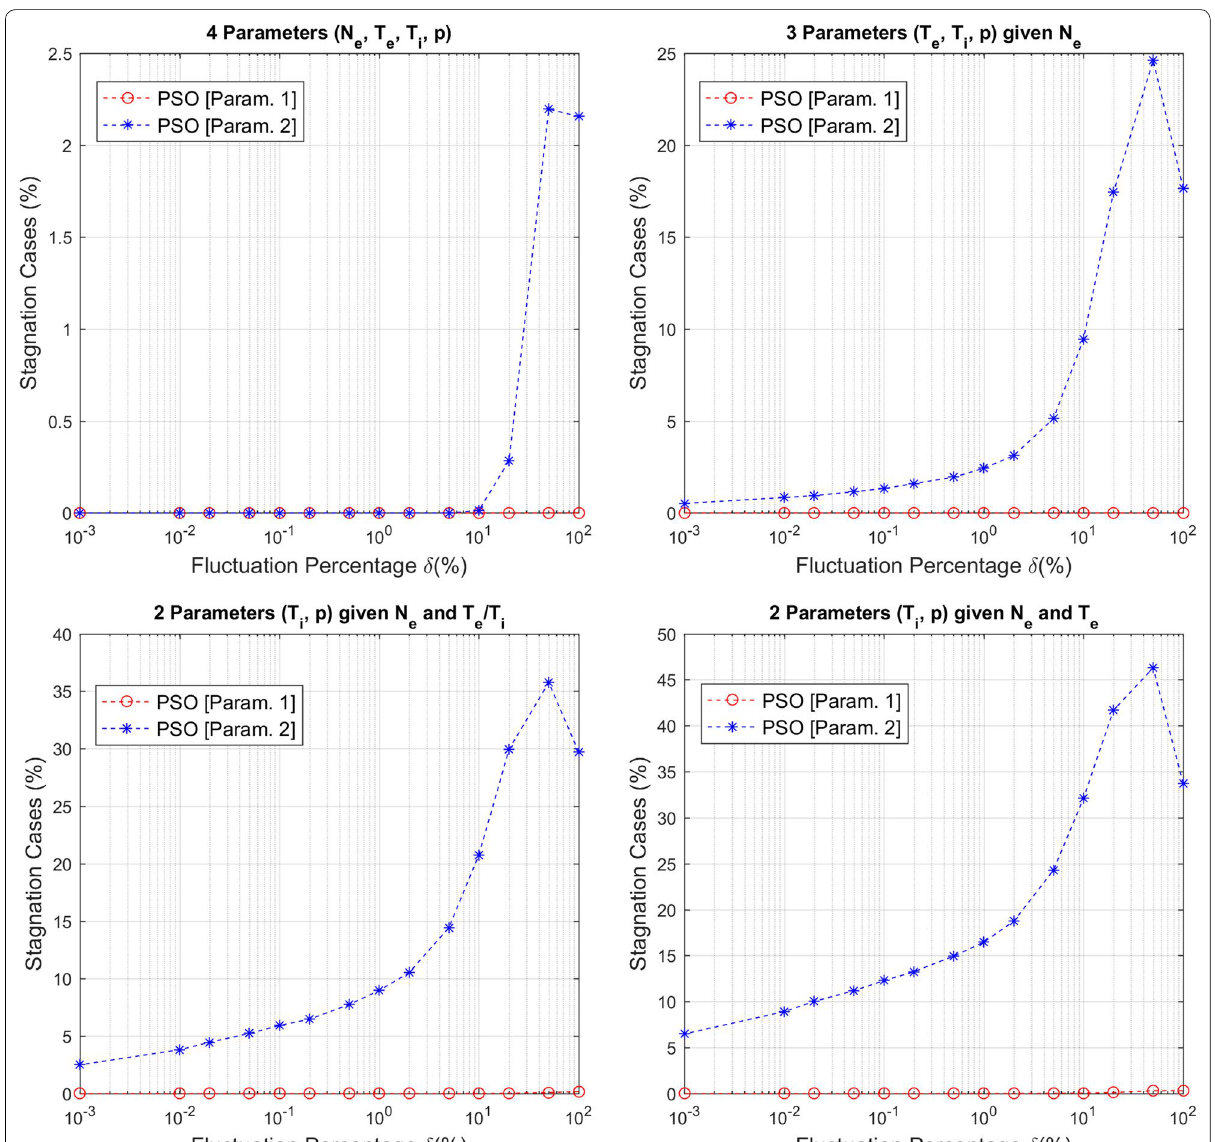
Fig. 9 Number of stagnation detections obtained by fitting simulations using the PSO algorithm with the configurations of PSO parameters “Param. 1” and “Param. 2”. Simulations were done estimating different combinations of known a priori plasma parameters from the plasma line at different signal fluctuation percentages ( δ( % )